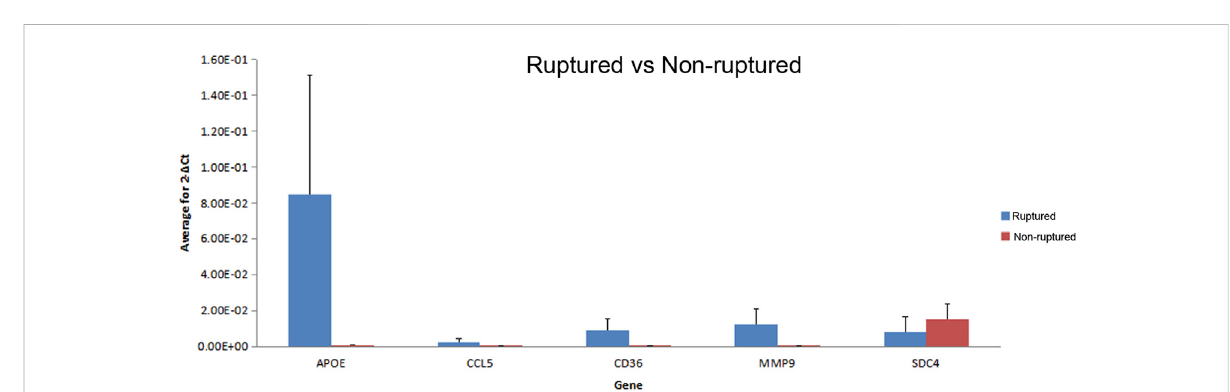
FIGURE 6 The veri fi cation results of randomly extracted differential expression